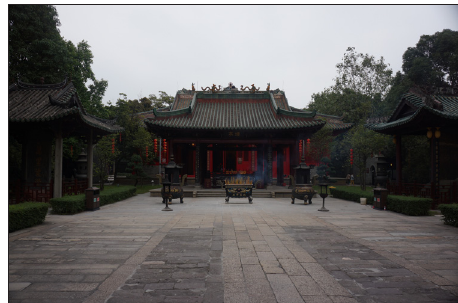
Figure 3: South Sea God Temple, Huangpu District, Guangzhou, Southern China, orig- inally built in 594 CE (Photo Tim